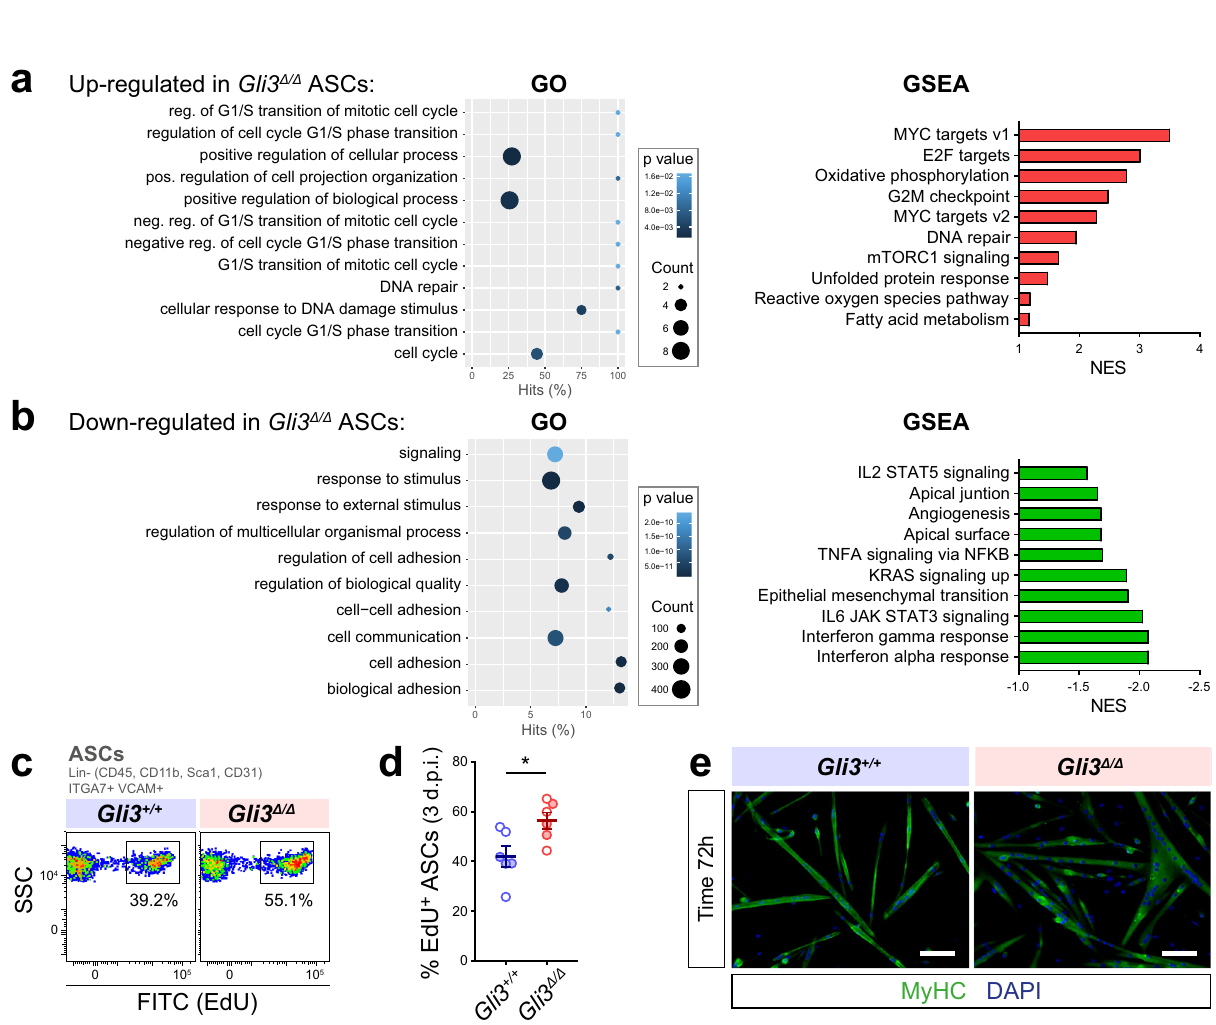
Fig. 5 Quiescent satellite cells in Gli3 Δ / Δ uninjured muscle are in G Alert . a Experimental design. QSCs and ASCs from TA and gastrocnemius (GA) muscles were analyzed for cell size, RNA content, and mitochondrial mass. FACS-isolated SCs were plated 40h with EdU to analyze cell cycle entry. Phosphorylation of S6 ribosomal protein was analyzed on freshly isolated EDL myo fi bers. b Principal component analysis of global transcriptomes of Gli3 + / + and Gli3 Δ / Δ QSCs and ASCs and Pearson ’ s values showing a correlation between samples. Each dot represents the mean of three biological samples. c Gene ontology (GO) term enrichment and gene set enrichment analysis (GSEA) for the upregulated and d downregulated genes in Gli3 Δ / Δ compared to Gli3 + / + QSCs. e Left, Representative plots of Gli3 + / + and Gli3 Δ / Δ QSCs stained for PyroninY (ASCs activated satellite cells, Unst. unstained). Right, Mean fl uorescence intensity (MFI) of PyroninY staining ( n = 4 males). f Left, Representative plots of Gli3 + / + and Gli3 Δ / Δ QSCs stained for MitoTracker Deep Red (MTDR). Right, MFI of MitoTracker ( n = 4 males). g Left, Immuno fl uorescence of phospho-S6 (pS6, red) in SCs (PAX7, green) on isolated Gli3 + / + and Gli3 Δ / Δ myo fi bers. Right, Proportion of pS6 + SCs ( n = 3 females). h Left, Immunostaining of SCs with PAX7 (green) showing EdU (red) incorporation 40h post- isolation. Right, Proportion of EdU + SCs ( n = three males, empty dots, and one female, colored dot). DAPI stains nuclei (blue). Scale bars, 10 µ m. Means± SEM; Unpaired t -test with Welch ’ s correction for panels e , f , g , h , * p < 0.05; ** p < 0.01; *** p < 0.001.